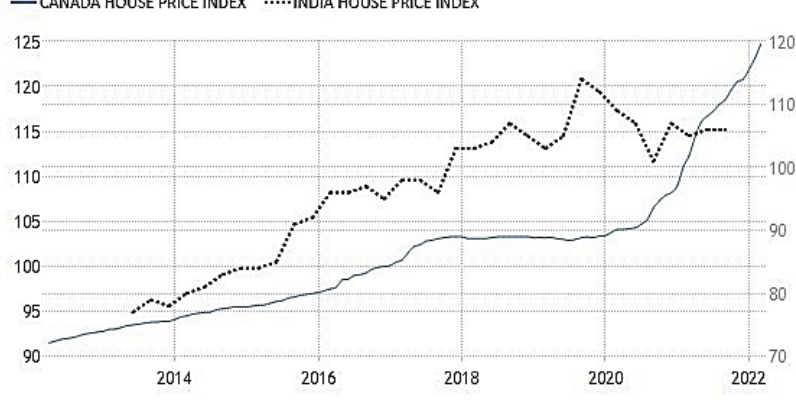
Fig. 2. House price index: India vs Canada. Source: (Trading Economics,